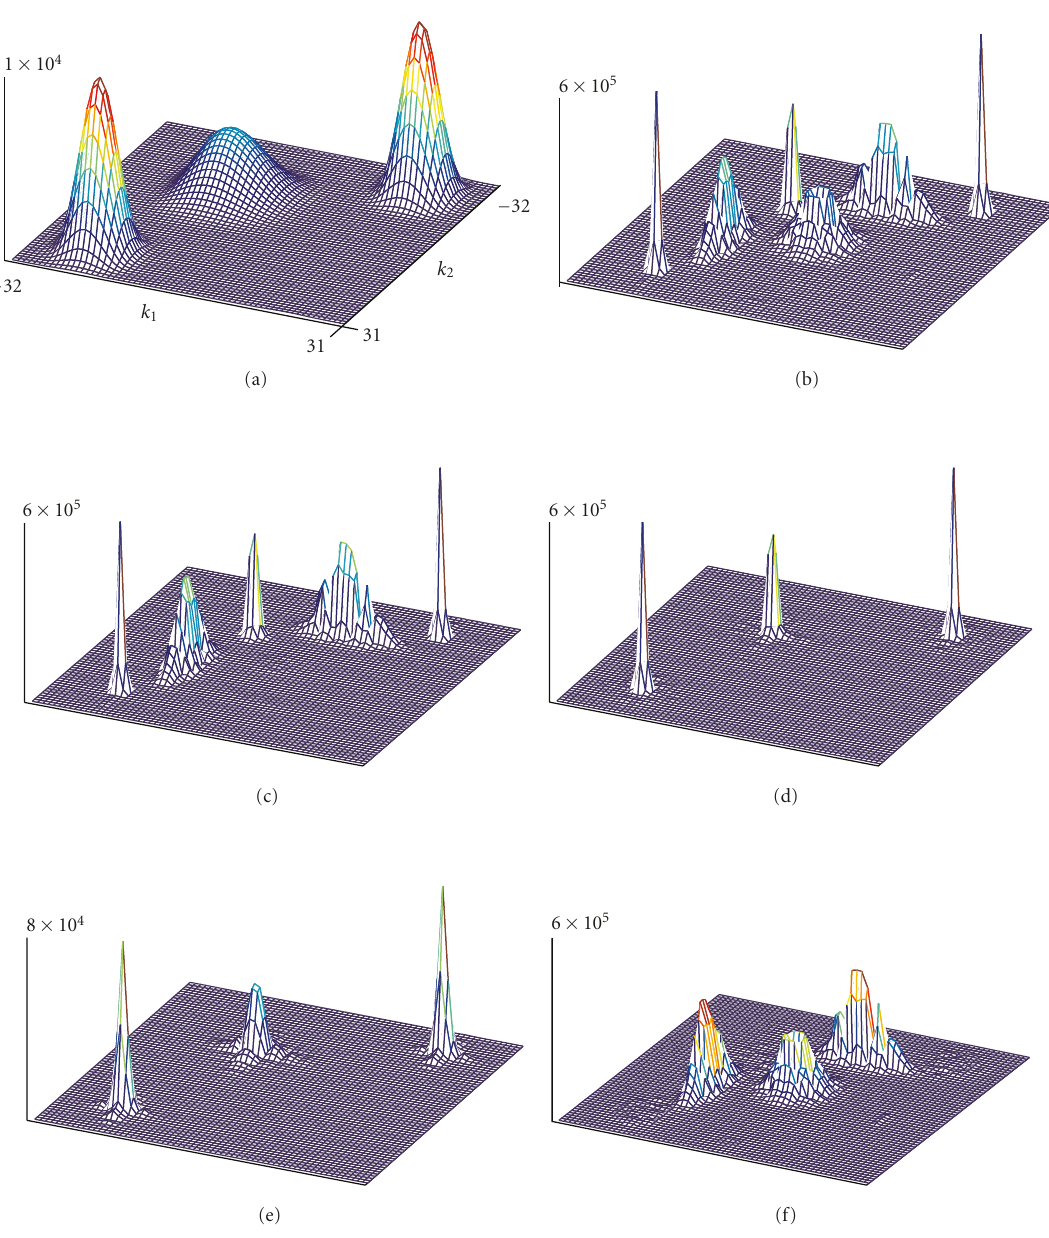
Figure 2: S/SF representations of signal (5): (a) 2D SPEC, (b) 2D WD, (c) 2D SM corresponding to the widest signal component, (d) Proposed method based representation, (e) S/SF representation having the same calculation complexity as the proposed method, (f) Di ff erence between graphics (b),